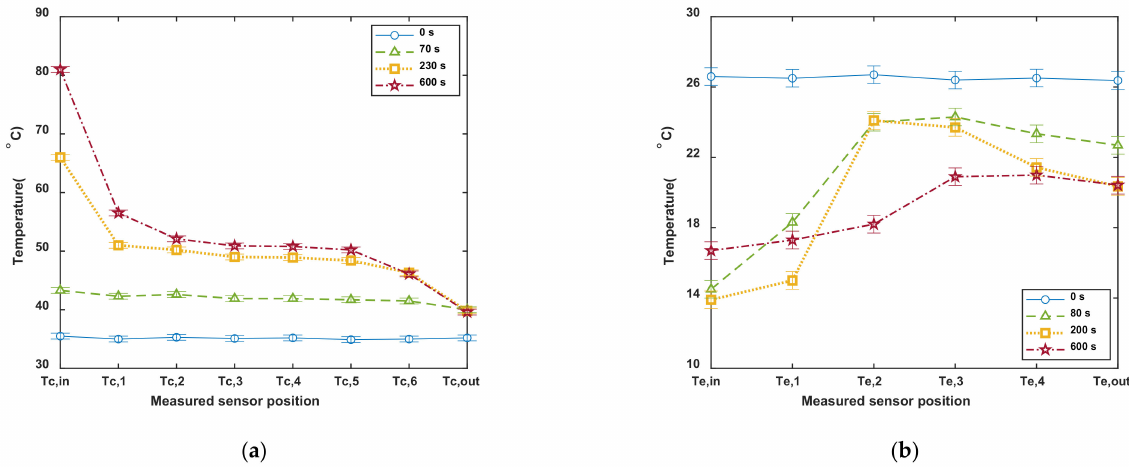
Figure 4. Temperature distribution in heat exchanger with rated refrigerant charge; ( a ) Condenser, ( b )